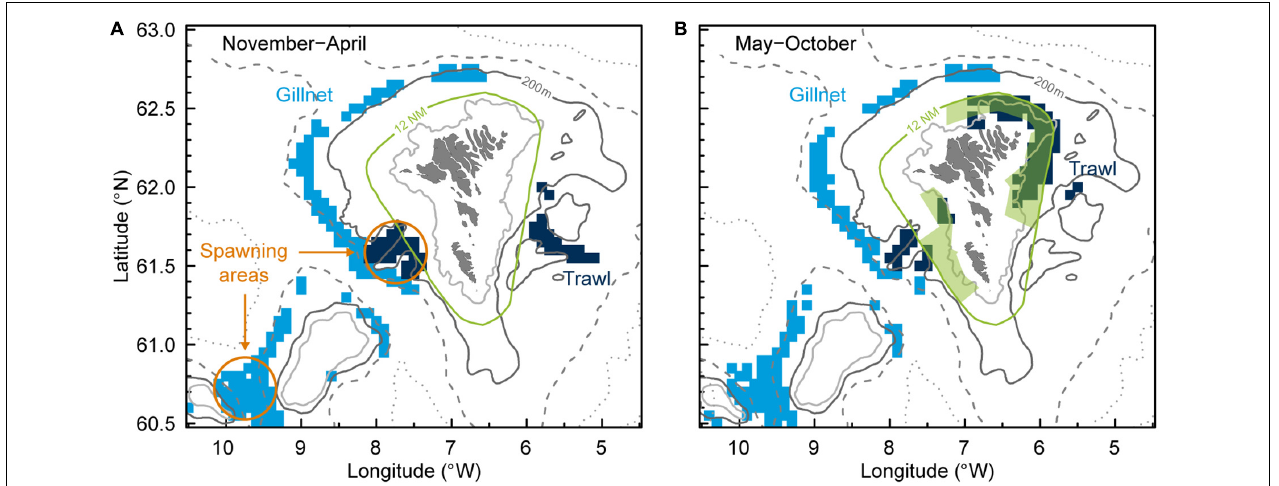
FIGURE 3 | Main anglerfish fishing areas in Faroese waters (anglerfish constituted more than 50% of the catch in weight per settings/hauls) are shown for gillnet and trawl less than 700 HP in panel (A) November–April and (B) May–October. Depth contours shown for 100, 200, 500, and 1,000 m. Anglerfish spawning areas are indicated as orange circles (Ofstad et al., 2013). Note that there are both annually and seasonally closed areas for trawling, on both the Faroe Plateau and Faroe Bank (ICES, 2021), and that some shallower areas inside 12 NM around the Faroe Islands are only open for small trawlers ( < 700 HP) during summer (green